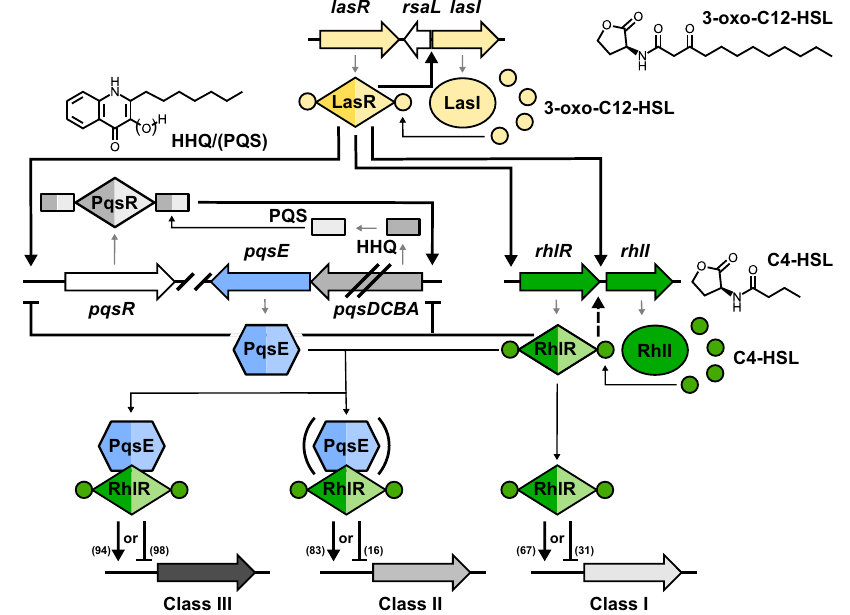
Fig. 1 | The quorum sensing network of P. aeruginosa . P. aeruginosa employs three QS circuits in a hierarchical, intertwined manner. The las system utilizes the homoserine lactone 3-oxo-C12-HSL as autoinducer for LasR, whereas the rhl and pqs systems use C4-HSL and 2-heptyl-4-quinolone (HHQ) or 2-heptyl-3-hydroxy-4- quinolone (PQS) to activate RhlR and PqsR (also termed MvfR), respectively. RhlR requires C4-HSL for up- or downregulation of target genes. The major part of the RhlRregulonisfurtherin fl uencedbyassociationwithPqsE,whichiseitherrequired